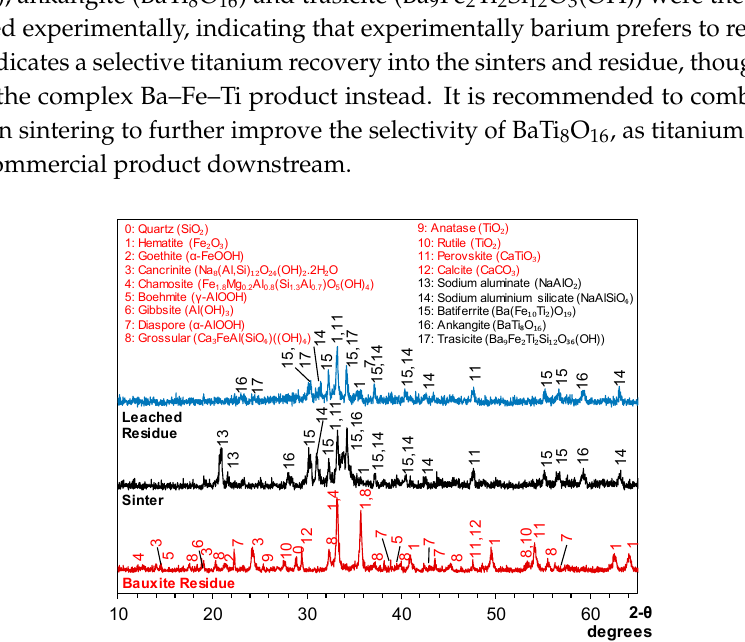
( b ) Figure 20. SEM mineral identifications in BaO, Na 2 CO 3 and bauxite residue ( a ) sinter products; (1) Barium titanate, and ( b ) Leached residue; (2) Barium titanium iron calcium aluminum silicon oxide (3) Barium iron calcium aluminum silicon oxide (more details in supplementary materials). 3.7. Experimental Results of Leaching Tests from 50% Excess Soda Sinters with CaO, MgO and BaO Additions The results of the leaching tests of Na 2 CO 3 only system, CaO + Na 2 CO 3 system, MgO + Na 2 CO 3 system and BaO + Na 2 CO 3 system as shown in Figure 21, further confirms the outcomes of the thermodynamic and experimental analysis. Aluminum recovery of the systems was in the range of 64% to 75% in total, with the highest to lowest recovery coming from BaO > Na 2 CO 3 > MgO > CaO added systems. The co-recovery of silica was higher in both Na 2 CO 3 only and MgO added system, at